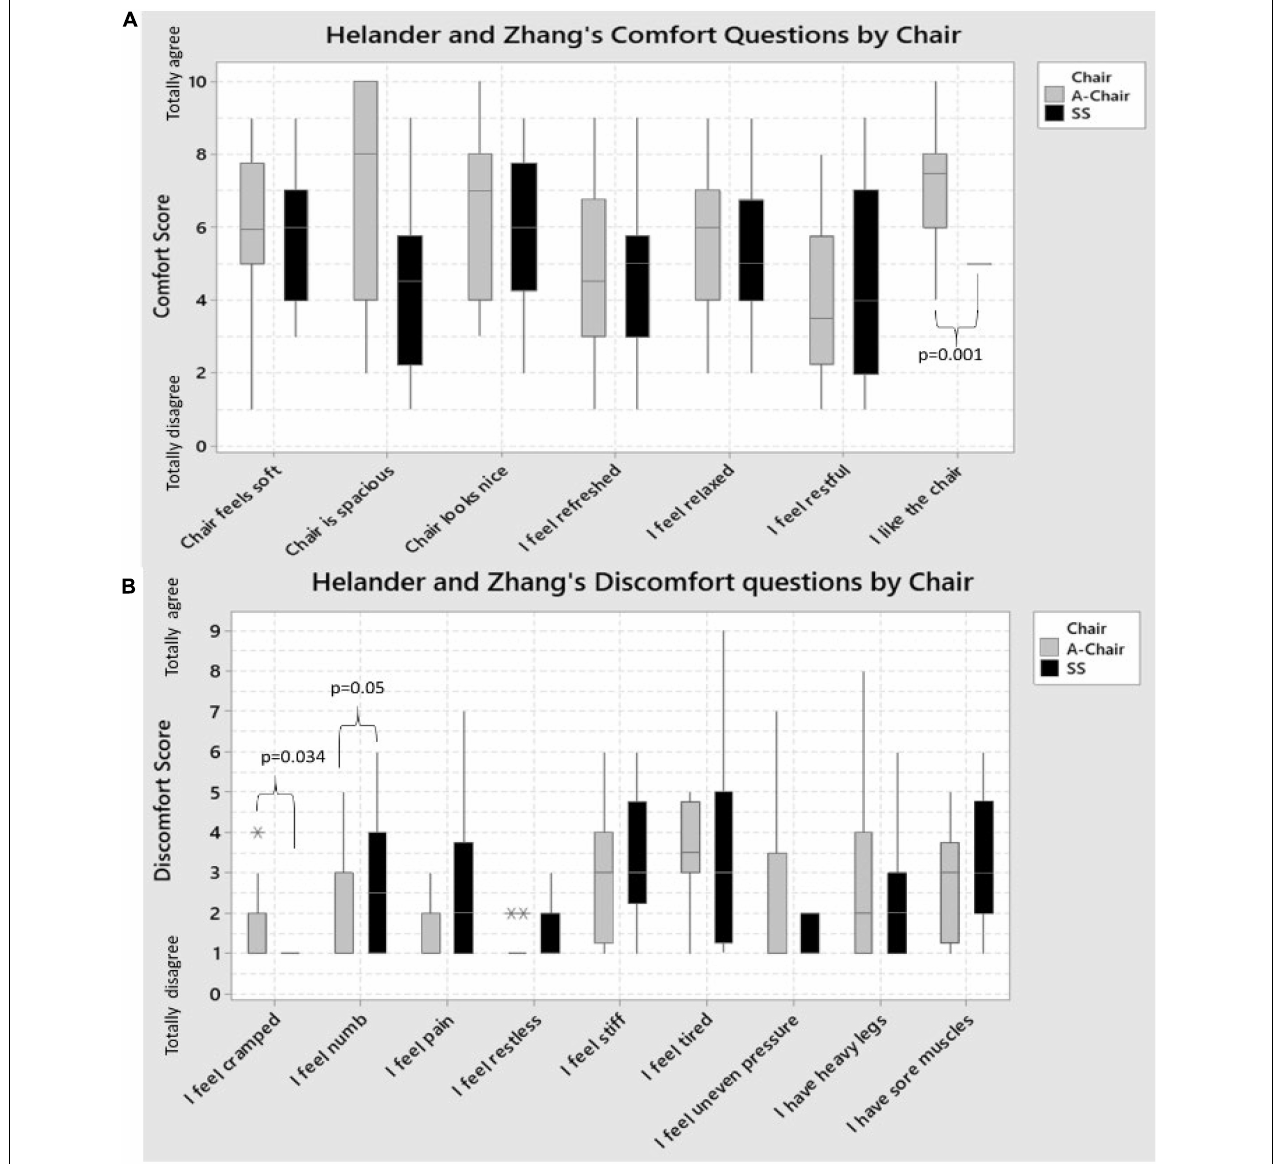
FIGURE 4 | Boxplots showing the Helander and Zhang’s statements of: (A) Comfort; and (B) Discomfort for the SS and A-Chair on the 16 pianist. For most Comfort questions (statements), the A-Chair had a better or equal score than the SS. The only exception was the restfulness of the chair: more pianists felt the SS was better than the A-Chair. The only statistically significant difference between chairs was “I like the chair,” with A-Chair being significantly more liked, than the SS. The sitting on the A-Chair was perceived as significantly “cramped” when compared to the SS ( p = 0.034), whilst the SS was perceived to provide greater numbness feeling ( p = 0.05) than the A-Chair. For the rest of the discomfort questions, no statistically significant difference was found, however, in five of the remaining seven statements, the pianists agreed the SS had a greater discomfort than with the A-Chair. Statistical outliers are indicated with * and